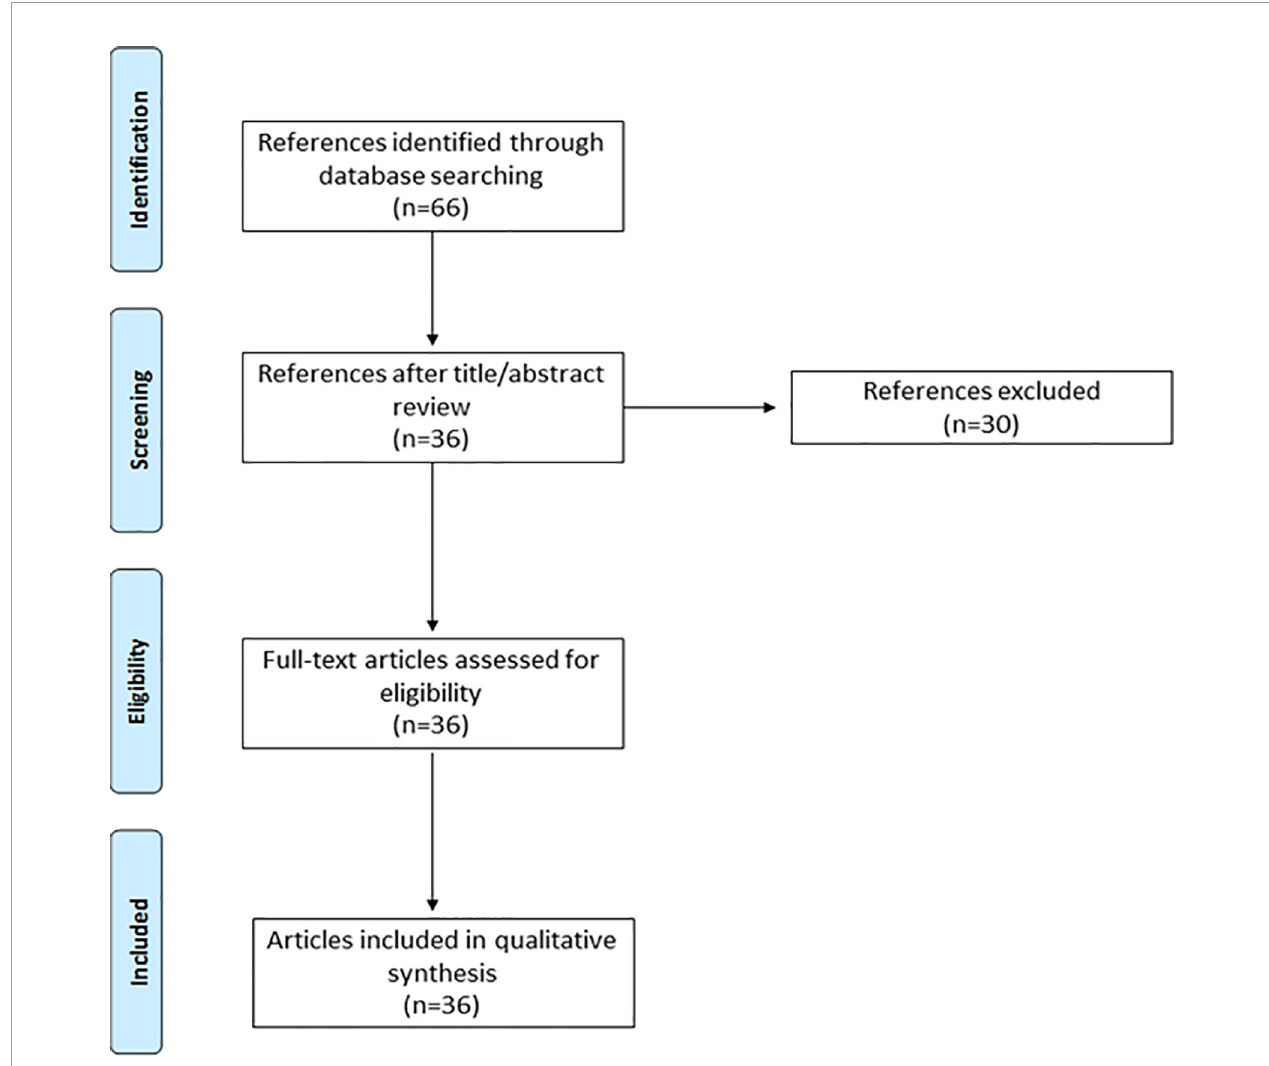
FIGURE 2 | PRISMA fl ow